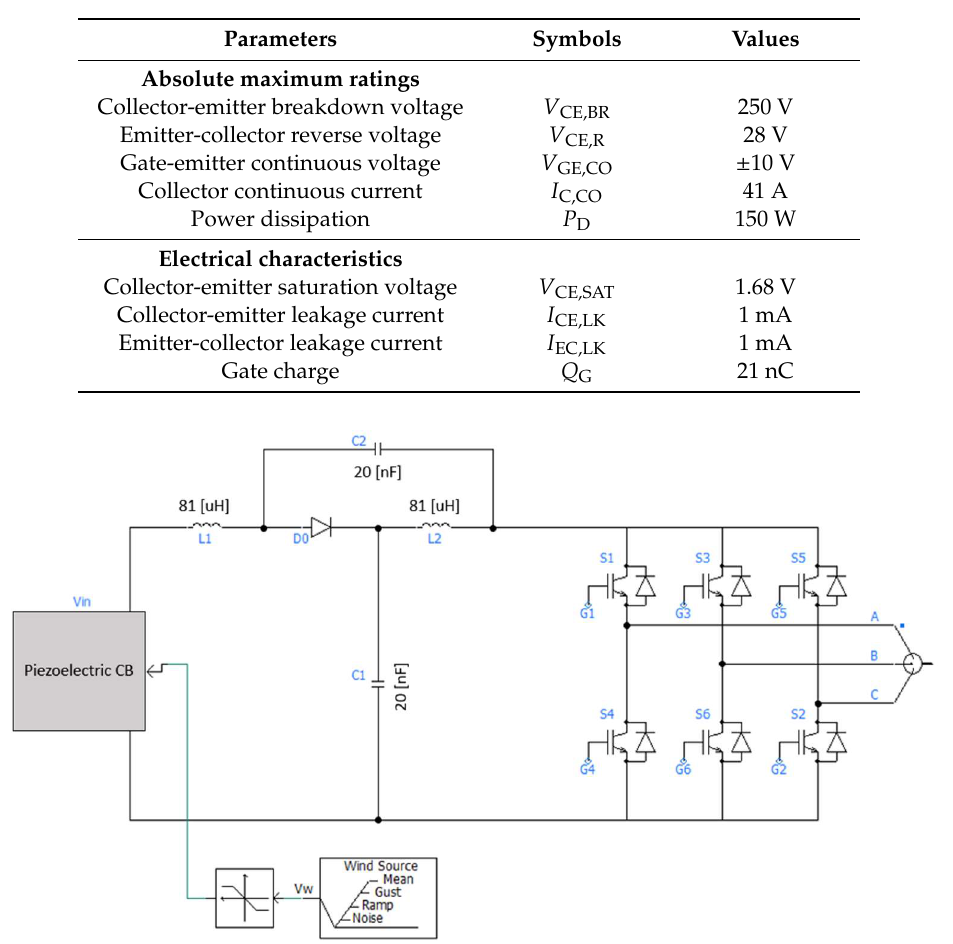
Figure 12. qZSI-based PVEH adopting wind source in PSCAD/EMTDC. Table 8. Arbitrary wind speed data input for the wind source.